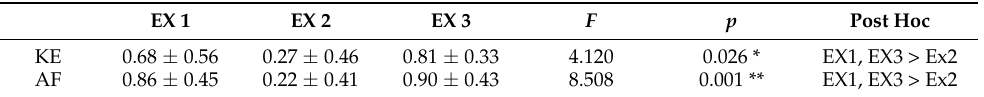
Table 3. Comparative analysis between groups using the average value of change between pre-test and post-test for